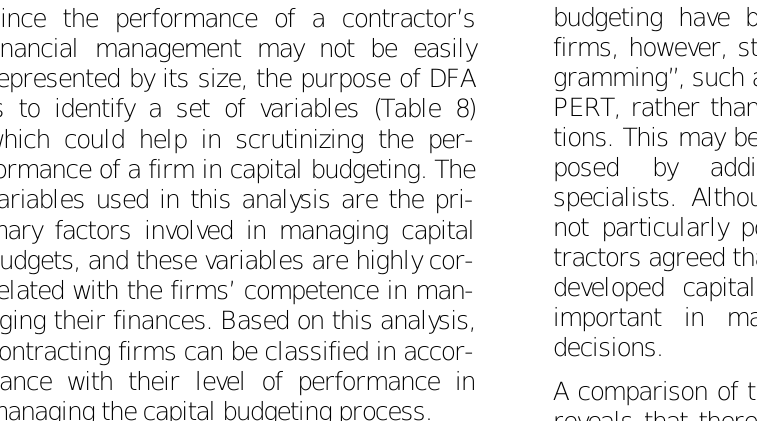
Table 10: Table of classification results from the discriminant function analysis (classified by size of firm) Group A ( < 20 M) 1 20 18 Group B ( < 50 M) 2 6 0 Group C ( > 50 M) 3 23 1 Percentage of “grouped” cases correctly classified: